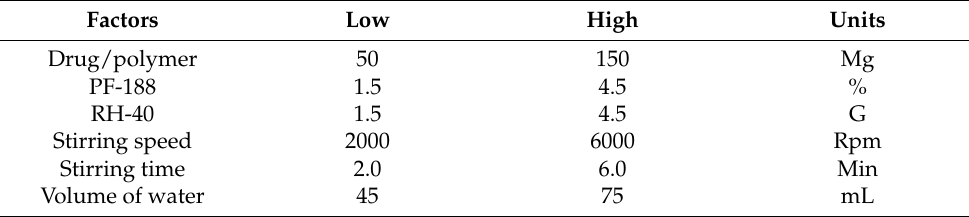
Table 1. Independent variables and levels selected for the screening design.